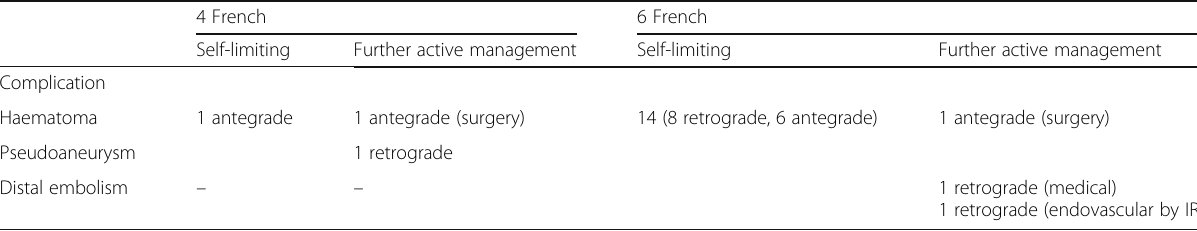
Table 3 Summary of complications between 4-Fr vs 6-Fr systems